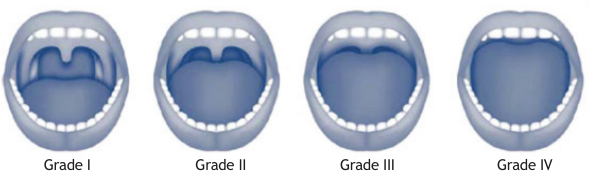
Figure 4 Modified Mallampati